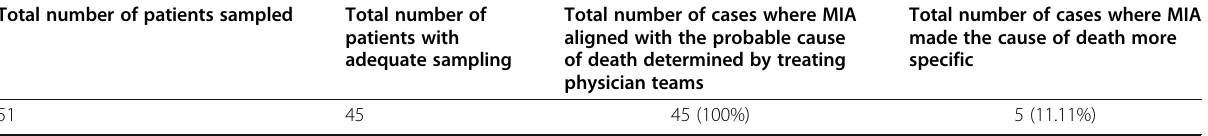
Table 3 Findings of MIA and their influence on the clinical cause of death Total number of patients sampled